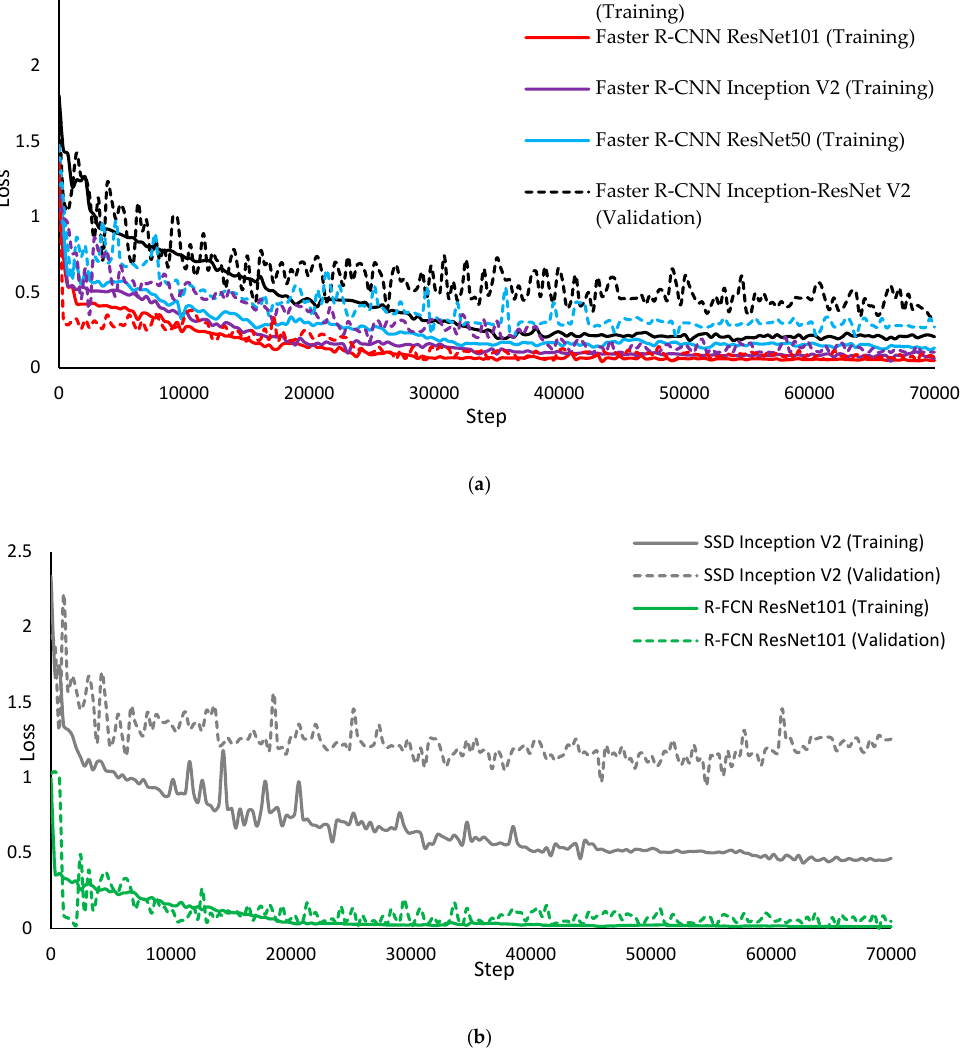
Figure 6. Training and validation loss during the ( a ) Faster R-CNN, ( b ) R-FCN and SSD training processes.